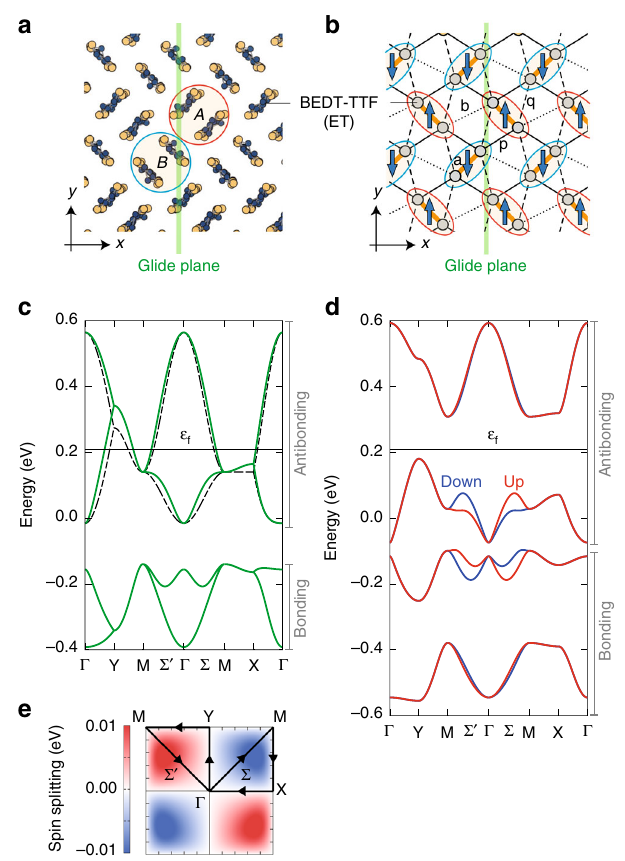
Fig. 2 Schematic illustration of the lattice structure of κ -Cl and the energy bands. a Molecular arrangement in the two-dimensional conducting layer. The red and blue circles represent the two kinds of ET dimers, termed A and B , respectively, in the unit cell. The green line denotes the glide plane perpendicular to the xy plane. b Network of the dominant electron transfer bonds, a (orange bold line), b (dotted line), p (solid line), and q (broken line). The gray circles represent the ET molecules, and the red and blue ellipses show the A and B dimers, respectively. The arrows represent the local spin moments in the AFM phase. We note that another glide plane exists when considering the layer stacking, but it does not affect our discussions. c Energy band dispersion composed of the frontier orbitals of ET molecules in the PM metallic phase with the transfer integrals ð t ; t ; t ; t Þ ¼ ð(cid:2) 0 : 207 ; (cid:2) 0 : 102 ; 0 : 043 ; (cid:2) 0 : 067 Þ eV (green solid line) a p q b and that of the single-band picture in the large dimerization limit (broken line). The average electron number in the unit cell is 6 and the Fermi energy ε is shown. d Energy band dispersion in the AFM insulating phase with the f intra-molecular Coulomb interaction U ¼ 1 eV, within the self-consistent mean- fi eld theory. e Contour map of the spin splitting subtracting the down-spin energy from the up-spin energy of the top band in d in the fi rst Brillouin zone. The trajectory shows the symmetric lines in c and gives rise to an energy band splitting depending on the spins, which has been overlooked previously. Figure 2d shows the band structure in the AFM state, calculated within the self-consistent mean- fi eld theory (see Methods). The spin splitting appears in the whole Brillouin zone except on the k -, k -axes and the zone x y boundary as shown in Fig. 2e.